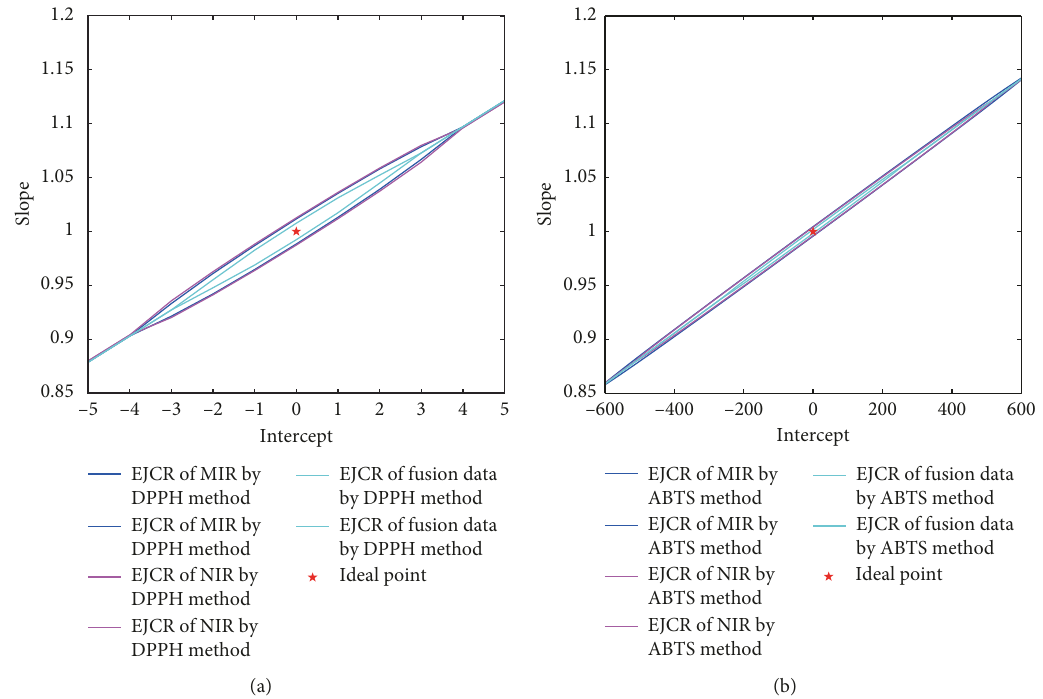
Figure 7: (a) EJCRs for DPPH scavenging activity by applying E-nose, E-tongue, and spectroscopic fusion data; (b) EJCRs for ABTS radical scavenging activity by applying E-nose, E-tongue, and spectroscopic fusion data. The pentacle ( ★ ) indicates the ideal points (0,